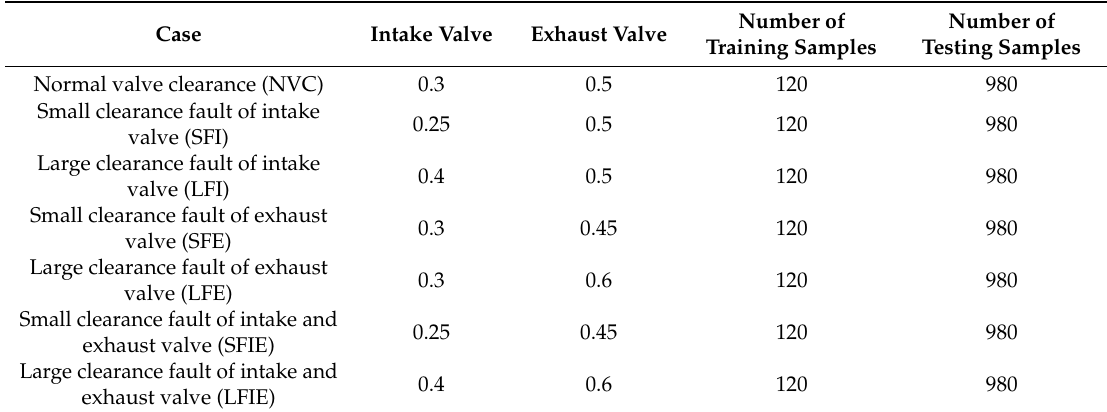
Table 1. Description of the valve state.